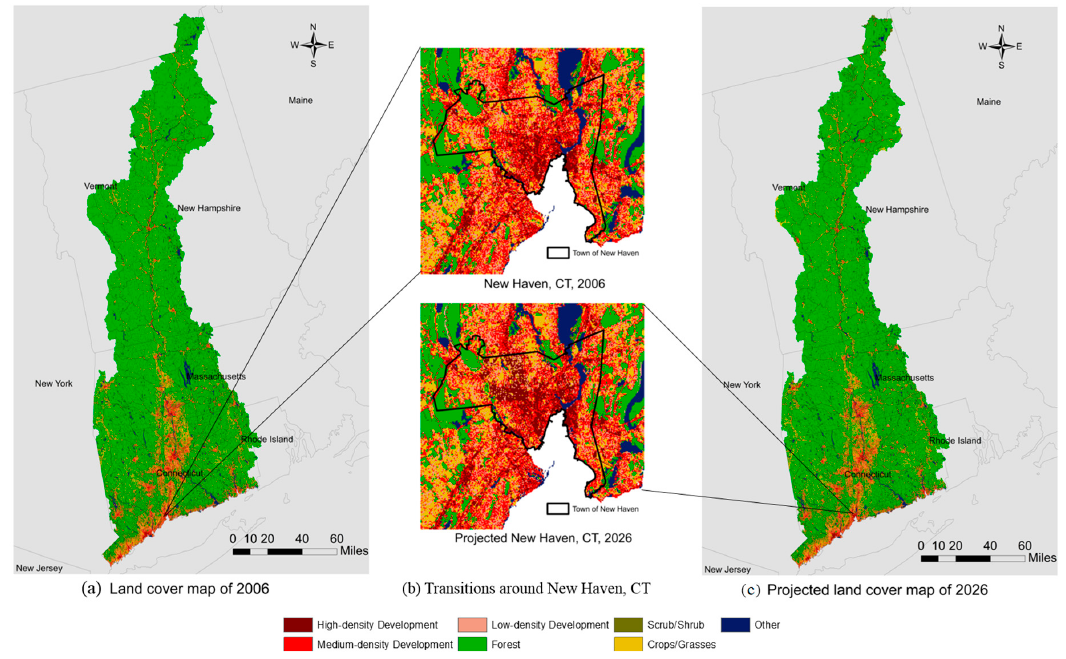
Figure 5. ( a ) 2006 land cover/use map, ( b ) transitions around New Haven, CT, and ( c ) projected 2026 land cover/use map by MLP–MC model. Table 4. Quantities of the predicted 2026 land cover/use classes in terms of hectare and percentage of each class.